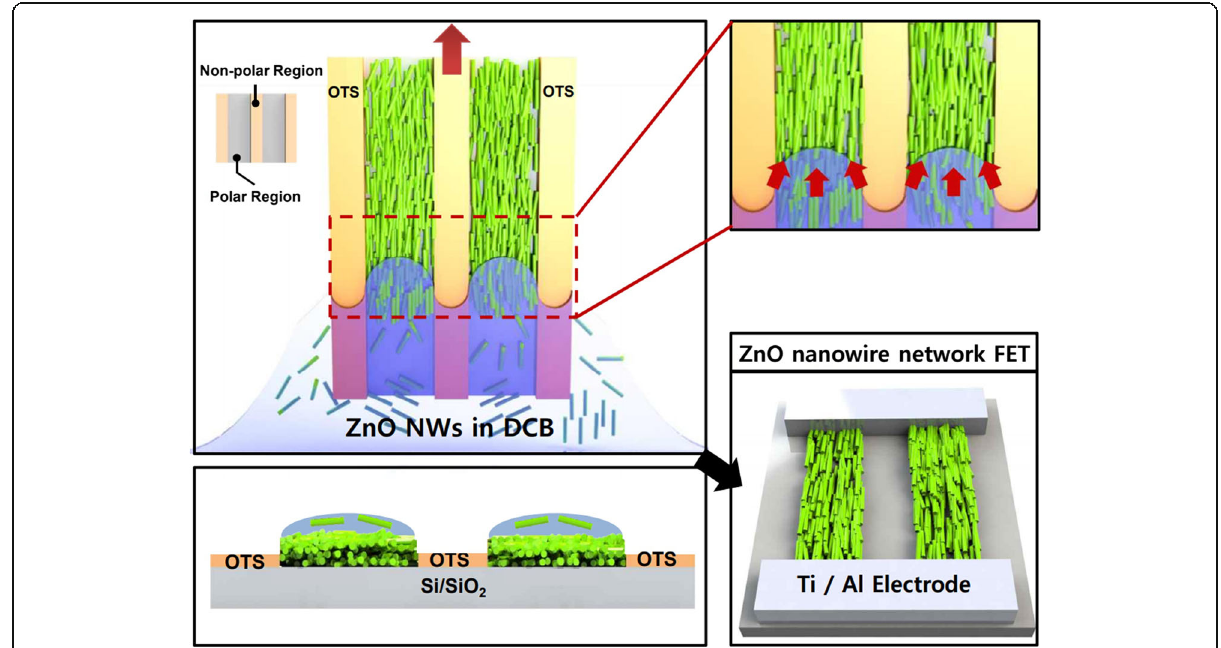
Fig. 1 Schematic diagram of the fabrication procedure of ZnO NW network FET. Assembly of ZnO NWs on molecularly patterned substrates using pulling